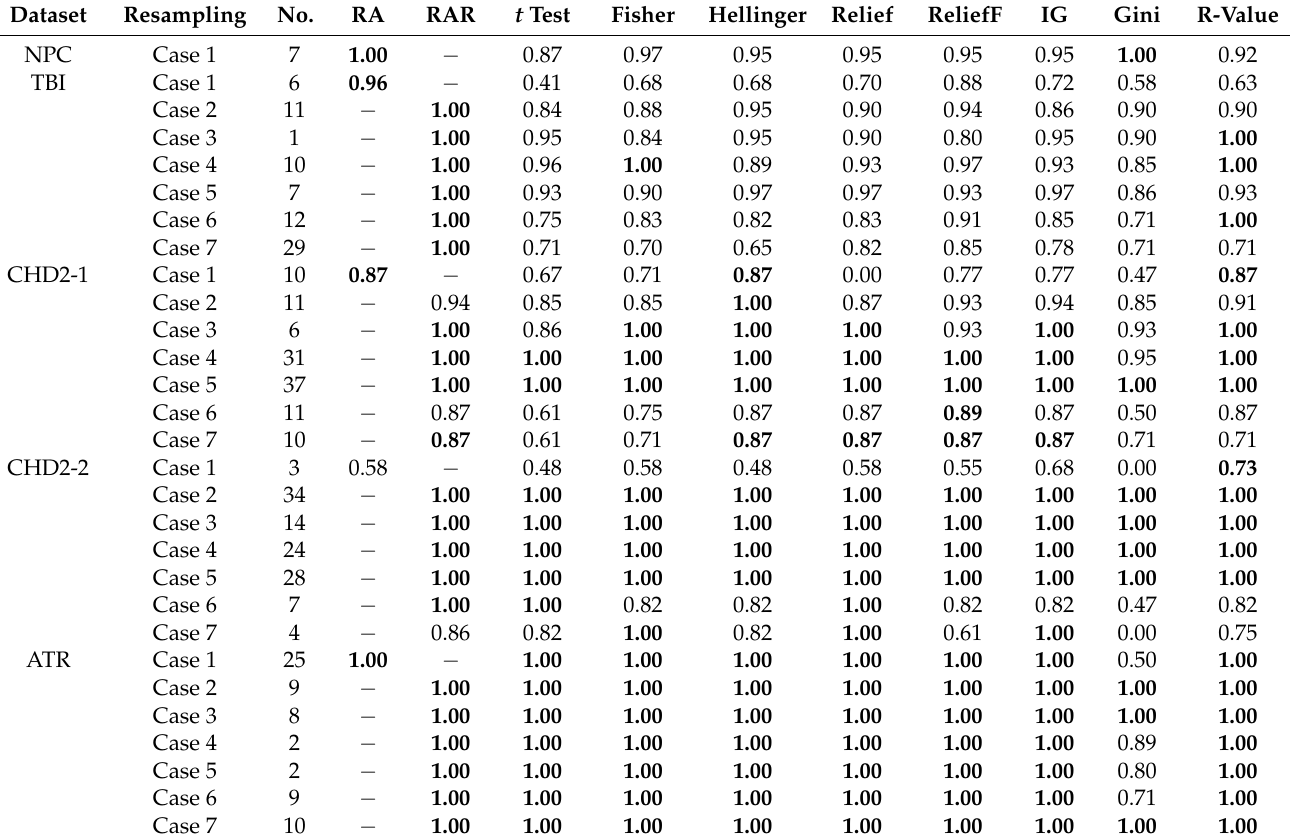
Table 1. Gmean from rank aggregation and eight filtering techniques (The best result is in bold).